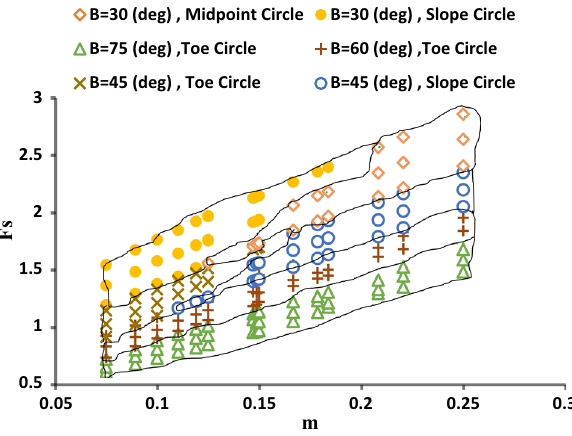
Fig. 7 Classification of slip type for slope angle and different